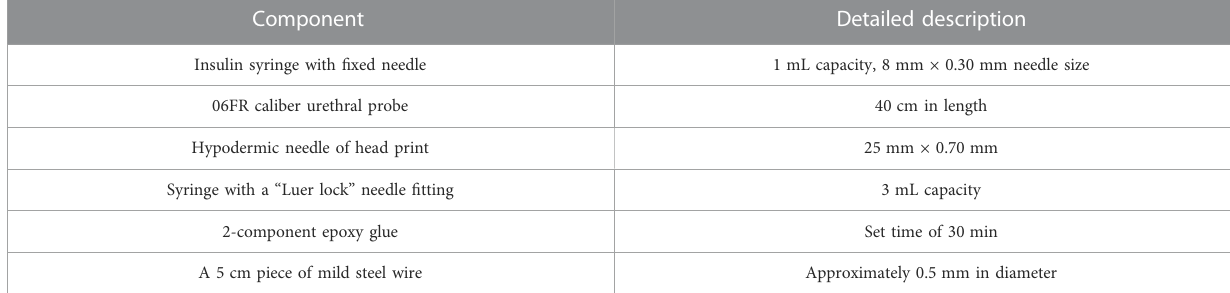
TABLE 3 Components used to build the prototype described here.